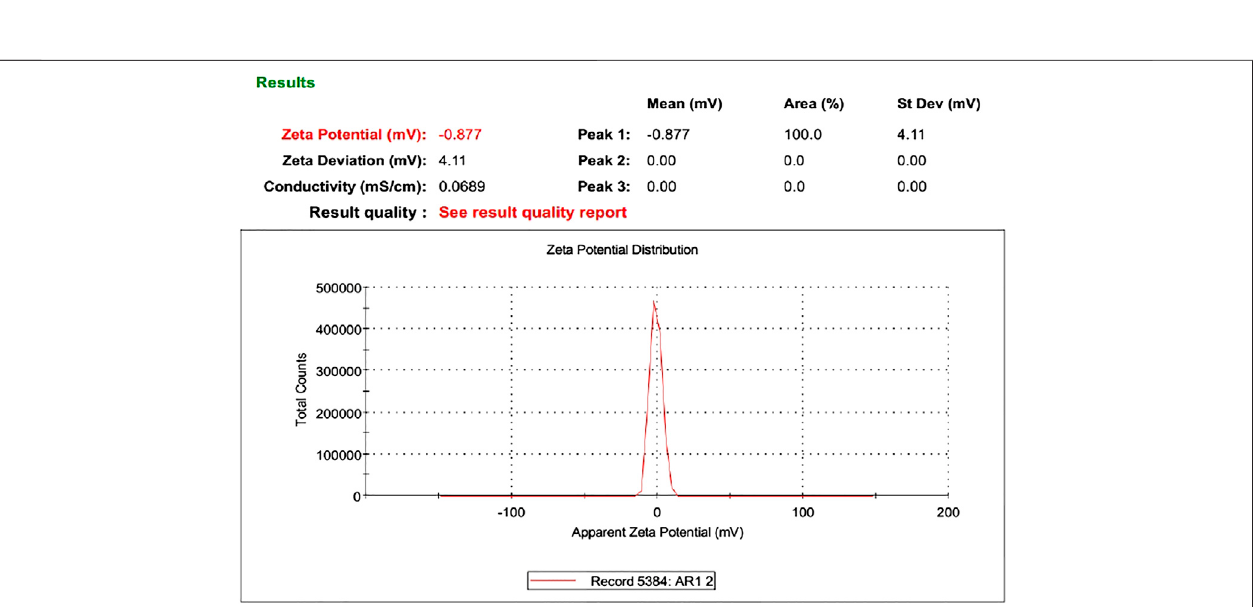
FIGURE 6 | Zeta potential of